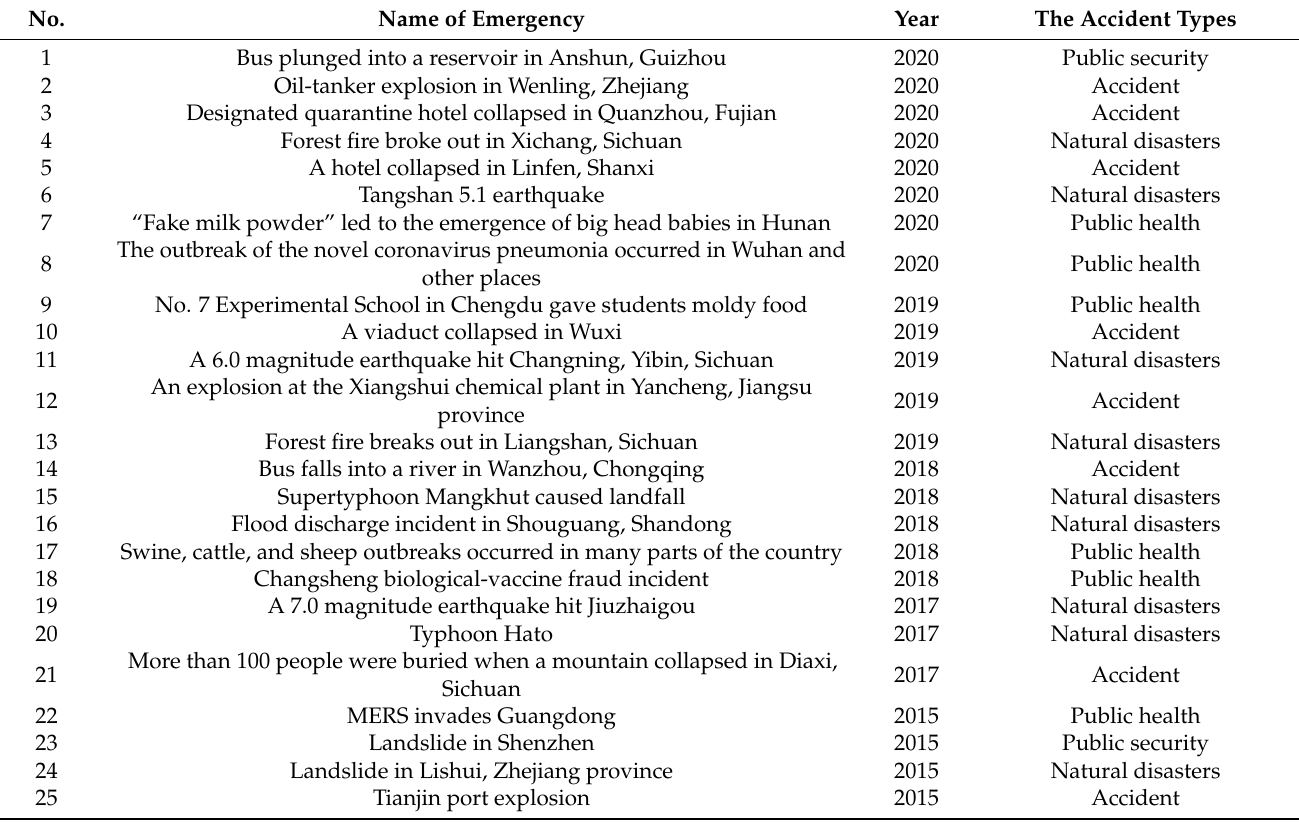
Table A1. 25 public emergencies that occurred in China between 2015 and